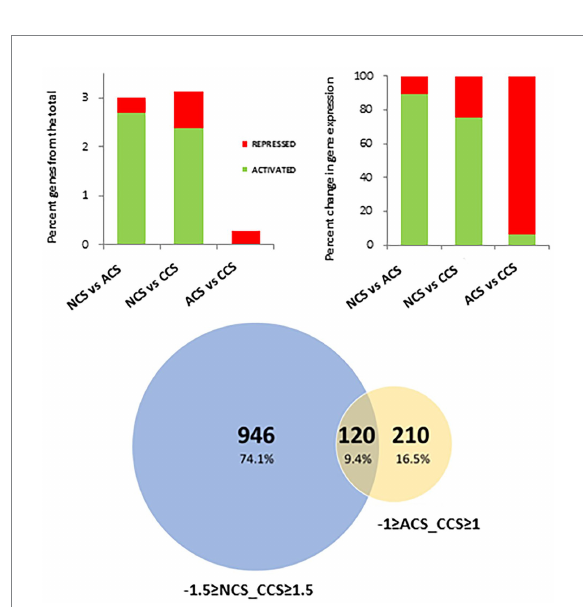
FIGURE 7 Differentially expressed genes across the different cold storage conditions. (Upper panel) Percentage of differentially activated or repressed genes at global level or among the comparisons: Non- cold stored (NCS) vs. air-cold stored (ACS), NCS vs. CO 2 -cold stored (CCS) and ACS vs. CO 2 -cold stored (CCS). (Lower panel) Venn diagram showing the number of DEGs in the comparisons, − 1.5 ≥ NCS vs. CCS ≥ 1.5 and-1 ≥ ACS vs. CCS ≥